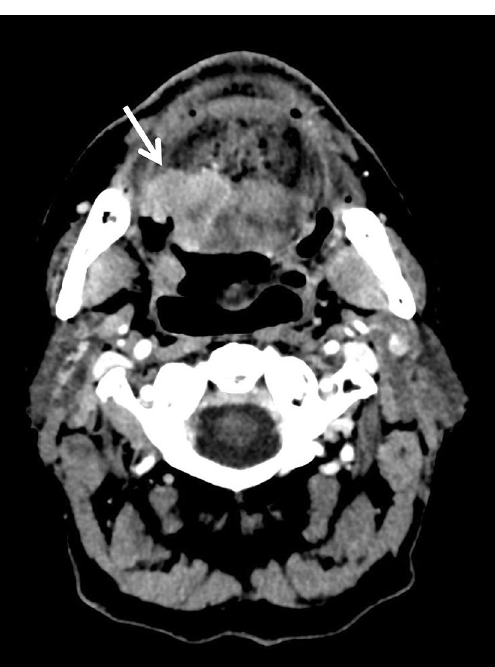
Figure 3. Axial CT slice showing a necrotic ulcerated (arrow) p16− tumour of the base of the tongue in a 59-year-old male former